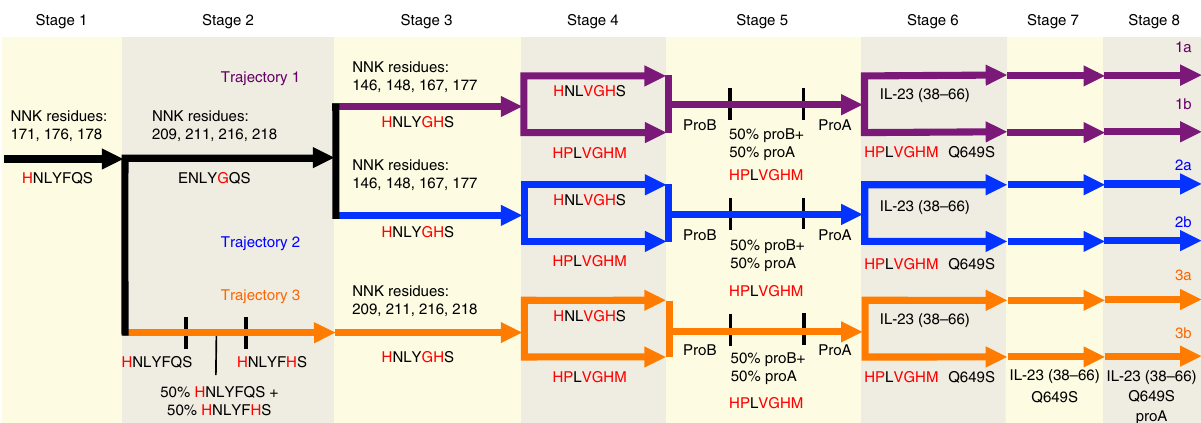
Fig. 2 PACE evolutionary trajectories. Across the eight stages of PACE along three diverging trajectories (shown in purple, blue, and orange), each arrow represents a PACE experiment with the corresponding substrate peptide and selection stringency parameters listed beneath the arrow. Increased selection stringency annotations are: Q649S (a T7 RNAP mutant with decreased transcriptional activity), proA (lower expression of substrate PA-RNAP), and IL-23 (38 – 66) (native IL-23 sequence in place of GGS linker). Numbers above the arrows denote TEV protease residues that were targeted in site-saturation mutagenesis libraries used to initiate that PACE experiment. In the fi rst PACE experiment, wild-type TEV protease was mutagenized at the positions shown. All other libraries were generated using the protease genes emerging from the previous PACE stage as the PCR template. For PACE stages with no targeted mutagenesis, lagoons were inoculated with an aliquot of the phage population from the preceding